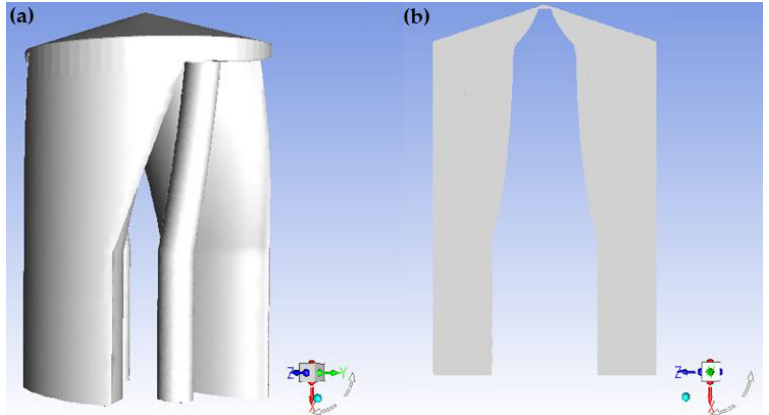
Figure 2. Geometry of benchmark case for comparison between open-source SPH code DualSPHysics and commercial code Ansys Fluent . ( a ) full geometry and ( b ) longitudinal section.